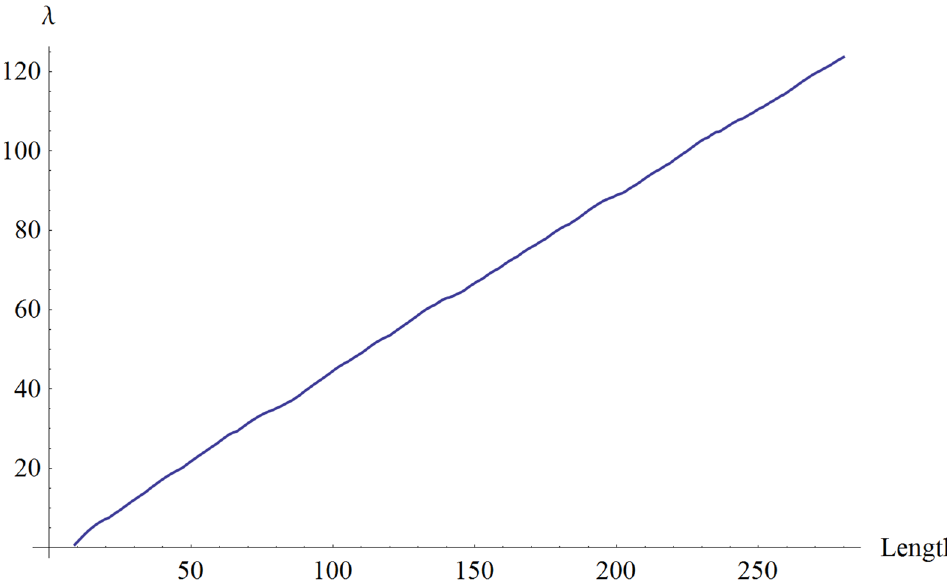
Figure 1. Scatterplot for λ. The abscissa axis shows the length of the candidate peptides, the ordinate axis shows the value of λ.